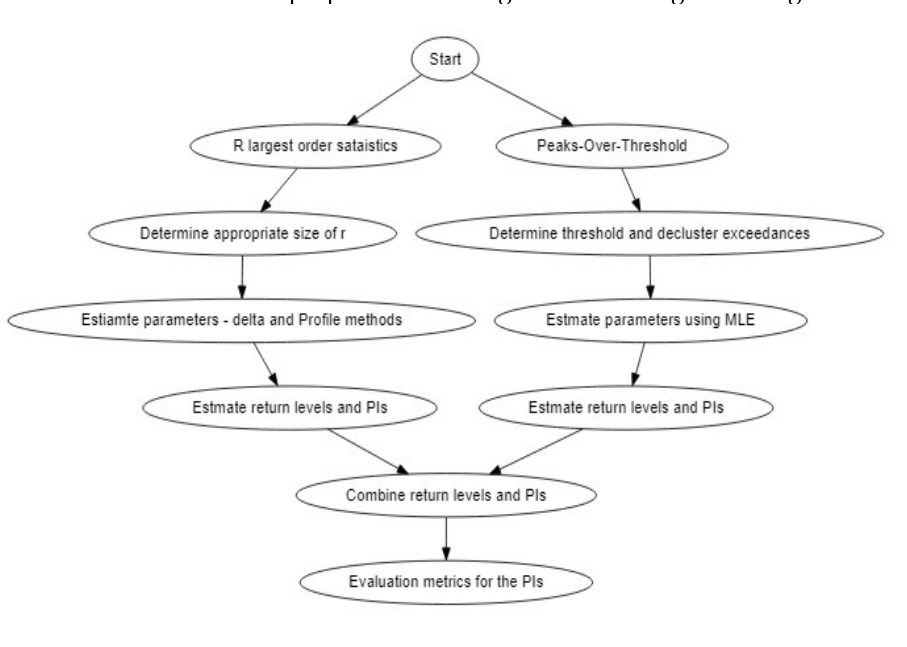
Figure 1. Flow chart of the